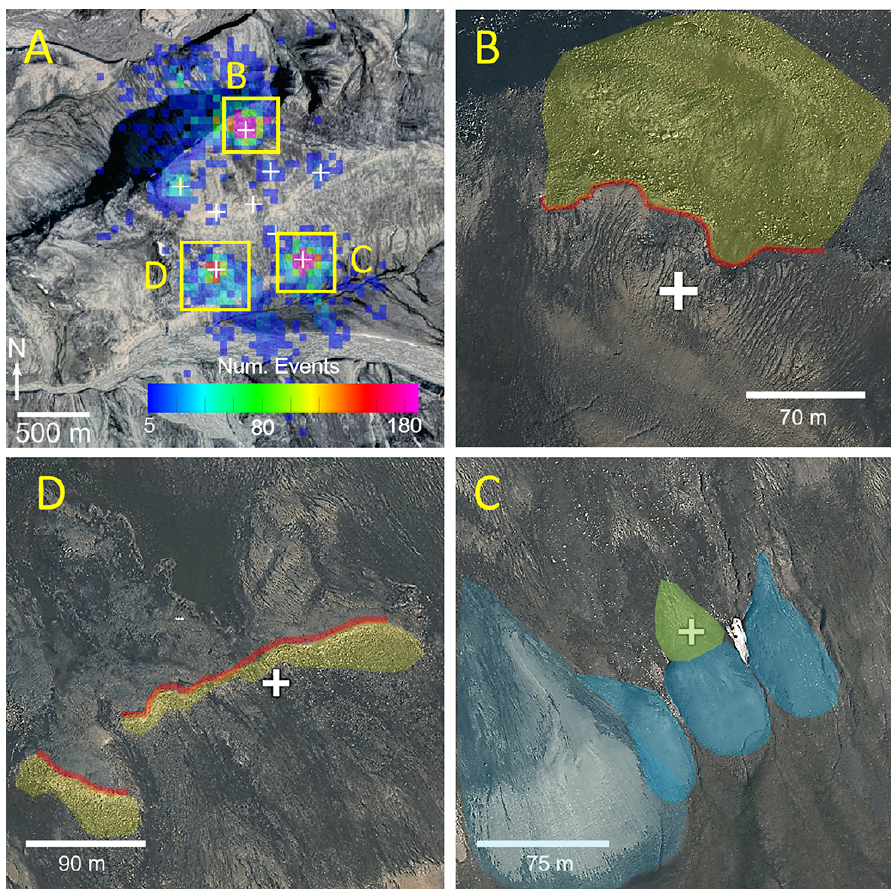
Figure 8. (a) December–February events as plotted in Fig. 7 with orthophotograph details illustrating the geomorphologic features associated with the most seismically active areas. Erosional scarps (b) and (d) are annotated in red with associated boulder fields in yellow, and frozen- debris/solifluction lobes (c) are annotated in blue. A faintly visible area of polygonally patterned ground is annotated in green in panel (c) . Orthophoto © Norwegian Polar Institute (https://www.npolar.no/, 17 January